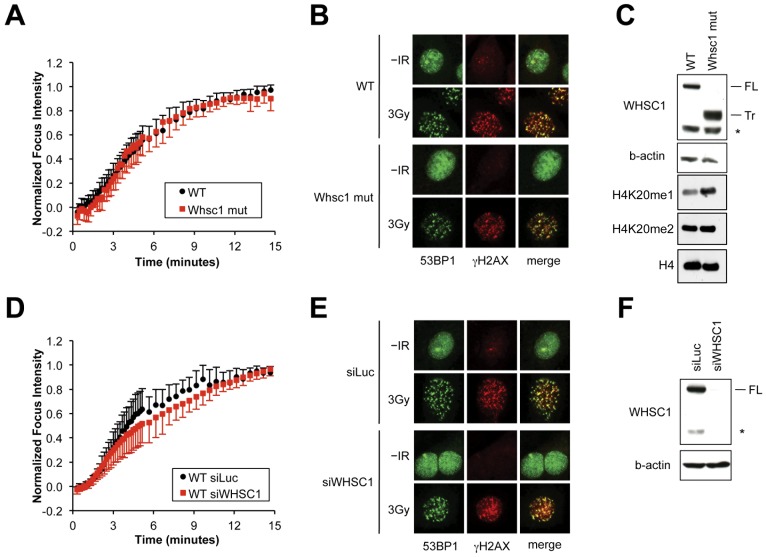
Impact of WHSC1 inactivation on 53BP1 DSB responses.
A)–C). Comparison of wild type (WT) vs. WHSC1mut/mut (Whsc1 mut) MEFs. D)–F) Comparison of wild type MEFs transfected with siRNA to Luciferase (siLuc; control sample) or WHSC1 (siWHSC1). A) and D) Plot of averaged mCherry-F53BP1 fluorescence accumulation over time normalized to a peak fluorescence intensity of 1.0 for each responding cell. Error bars indicate s.d.. B) and E) Endogenous 53BP1 and γH2AX focus formation in cultures 30 minutes following treatment with 3 Gy IR. C) and F) Immunoblot with antibody specific for WHSC1 N-terminus and for β-actin (loading control) in test cultures. FL = full length WHSC1, Tr = likely truncated WHSC1 gene product, * = unidentified band, a potential MHSC1 gene product in view of its depletion by siWHSC1. Panel C also shows abundance of mono- and di-methylated H4K20 in WT vs. WHSC1
mut/mut MEFs, with histone H4 as a loading control. Note slightly increased abundance of H4K20me1 in WHSC1
mut/mut MEFs.